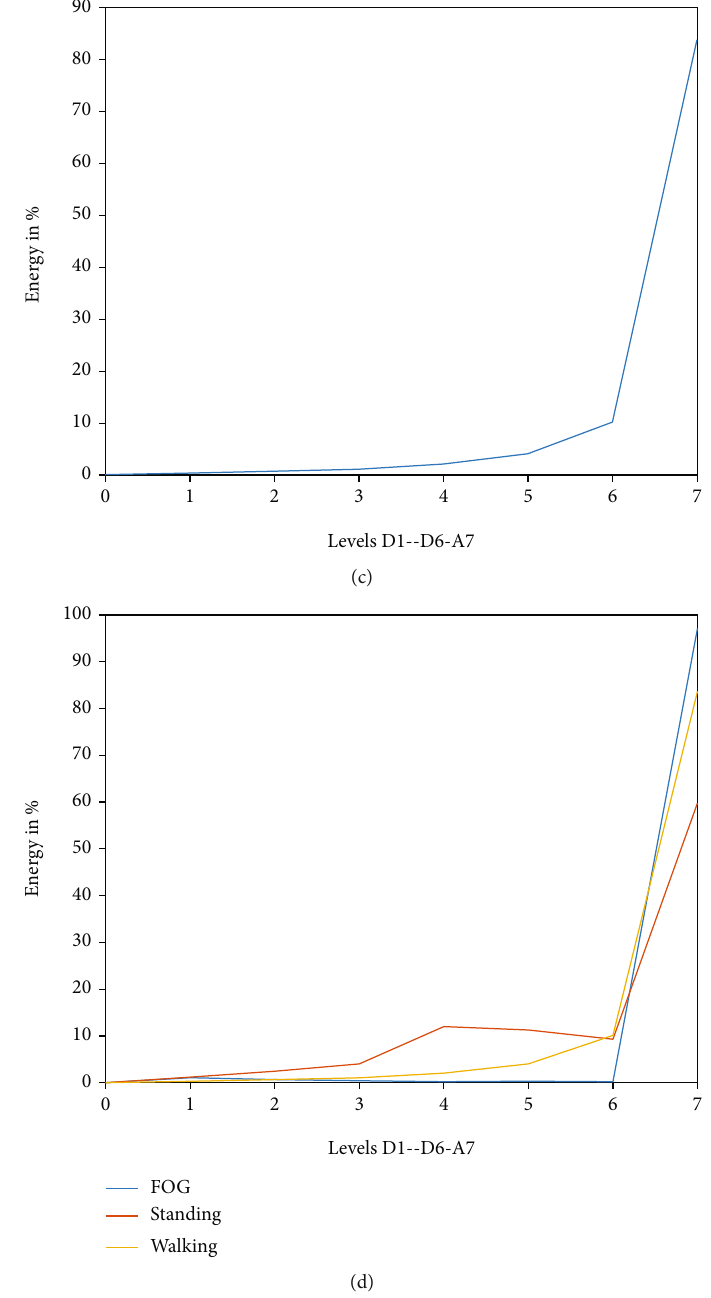
Figure 4: Energy distribution graph up to 6 th level for FOG, standing, and walking: (a) energy distribution for FOG; (b) energy distribution for standing; (c) energy distribution for walking; (d) cumulative energy